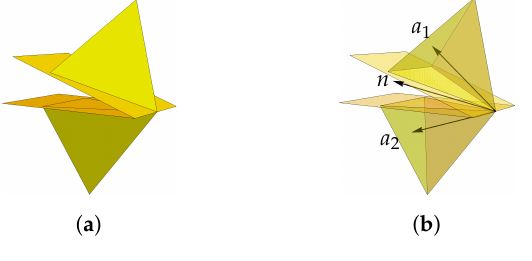
Figure A3. Example of 2 vertex-sharing tetrahedra with accompanying face planes: ( a ) shown opaque for visual clarity, particularly where the shared vertex lies on the intersection line of the face planes; and ( b ) shown partially transparent, so the centroid axes a i and angle bisector n can be seen. That intersection line between the two face planes contains all points common between